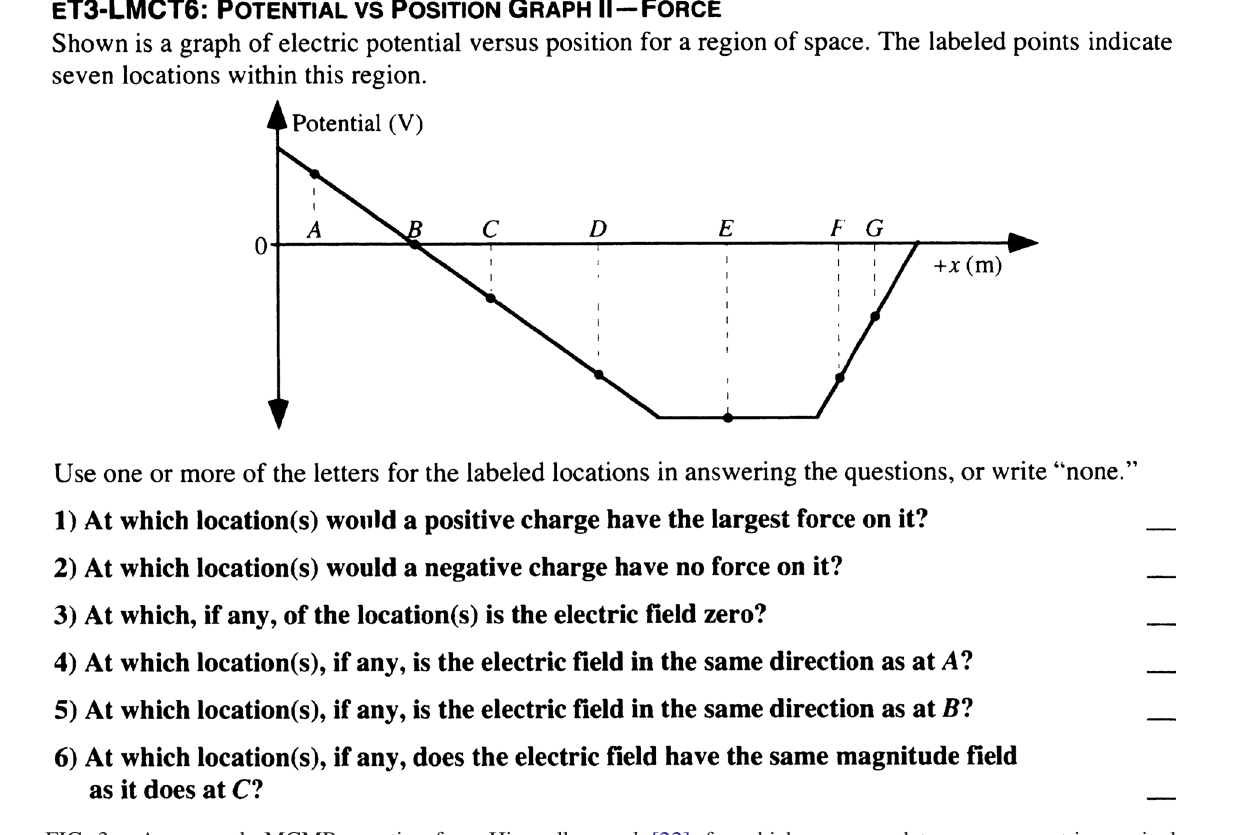
FIG. 3. An example MCMR question from Hieggelke et al. [22], for which response data are asymmetric